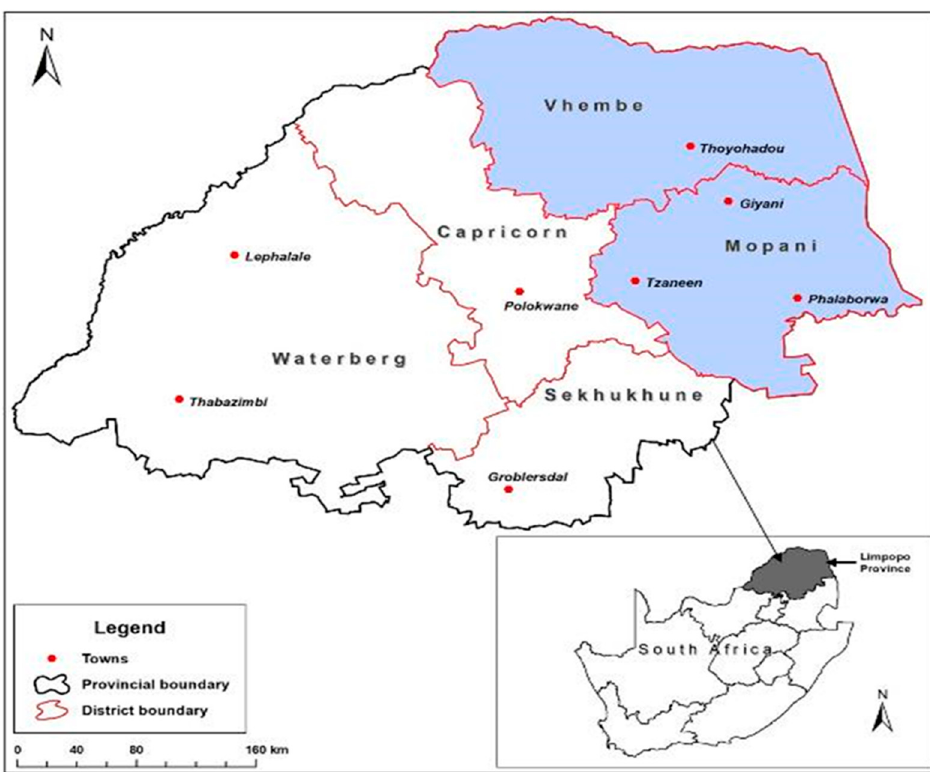
Figure 1. Limpopo Province map showing the location of Vhembe and Mopani districts.